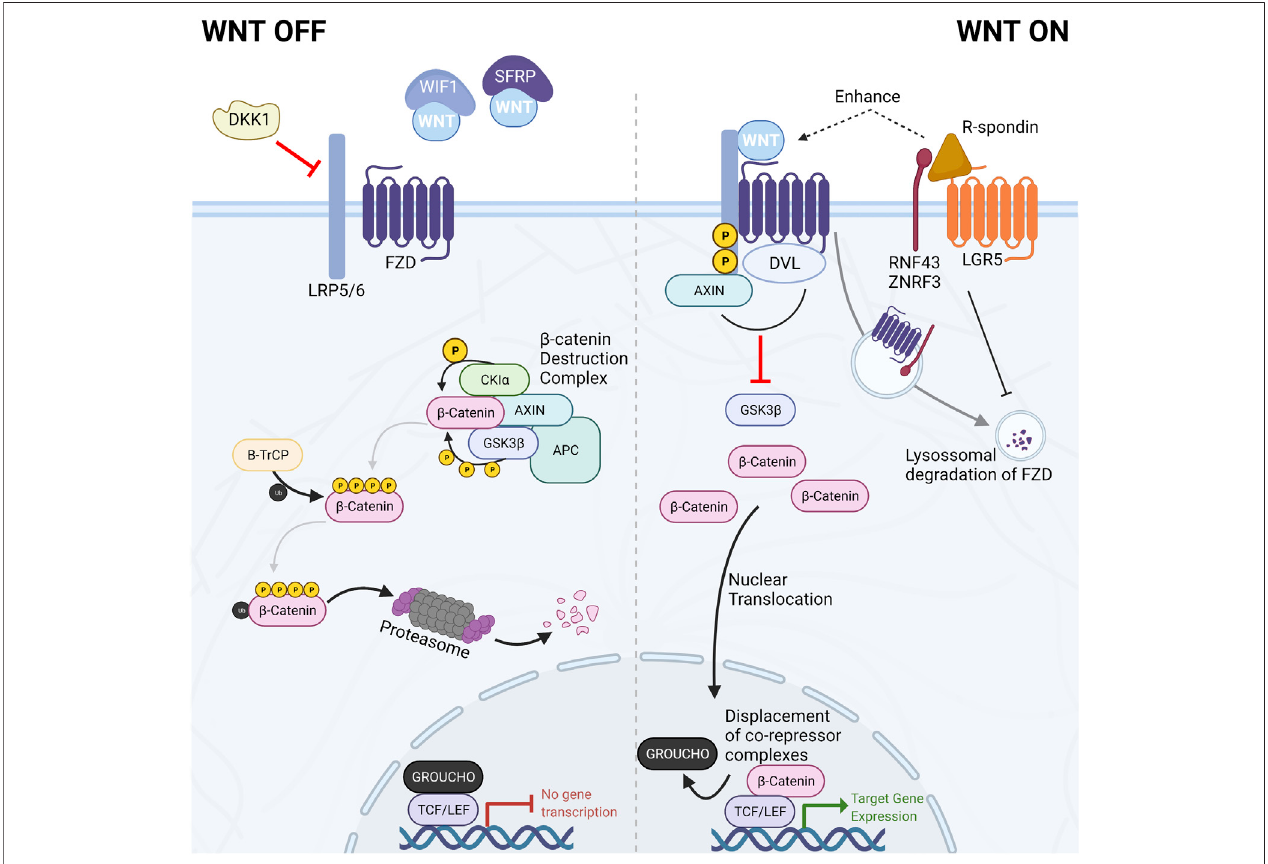
FIGURE 2| The Canonical Wnt/ β -catenin signaling pathway. In the absence ofWntligands or in the presence of Wntantagonists such as DKK1, WIF1, or SFRPs, the Wnt signaling pathway is kept in the off state by the dynamic degradation of β -catenin mediated by the β -catenin destruction complex. This multiprotein complex is composed of the scaffolding proteins AXIN1/2 and APC and the kinases CK1 α and GSK3 β . The two kinases sequentially phosphorylate β -catenin, targeting it for proteasomal degradation. Conversely, when Wnt ligands bind the FZD/LRP co-receptor complex, the β -catenin destruction complex is disassembled. Consequently, β -catenin accumulates in the cytoplasm and translocates to the nucleus, where it displaces co-repressors bound to TCF/LEF transcription factors, thereby initiating Wnt-target gene expression. R-spondins can amplify Wnt ligand response and increase cellular sensitivity to Wnt ligands by inhibiting the recycling of FZD